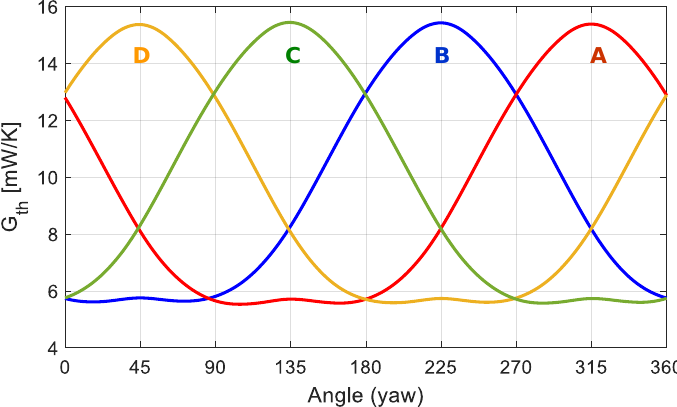
Figure 26. Evolution with the yaw angle of the average convective heat transfer coefficient G th of each sector of the sphere at Re = 10,000. These values have been obtained by integration from LES results. Sector names correspond to those defined in Figure 25. The disposition of the sectors A, B, C and D is the same the one shown